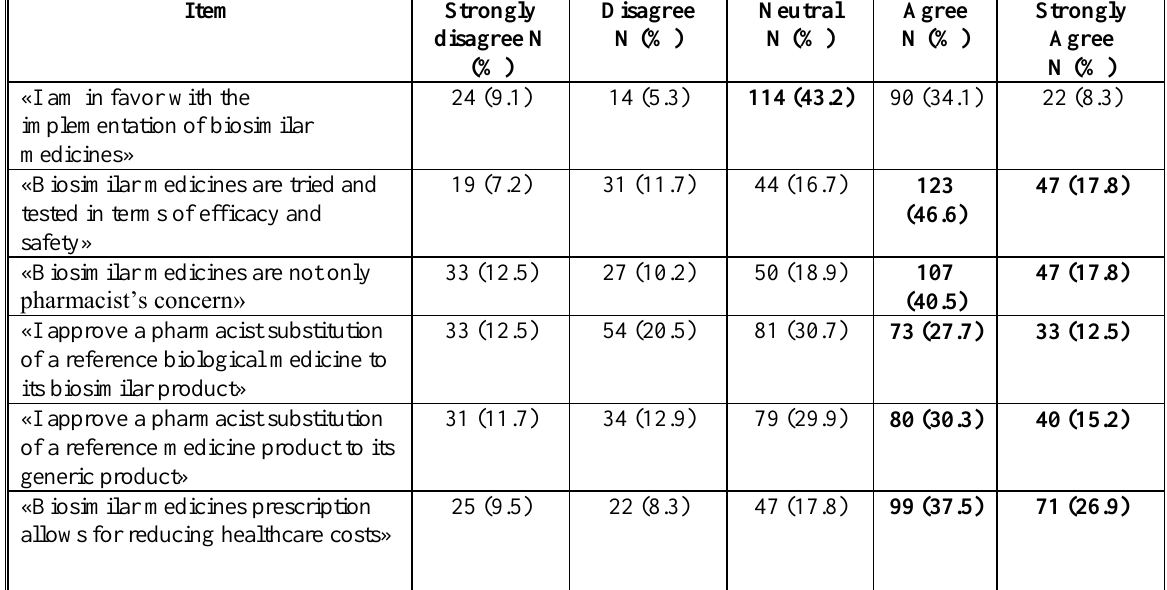
Table 6. Pharmacists’ perceptions about biosimilar